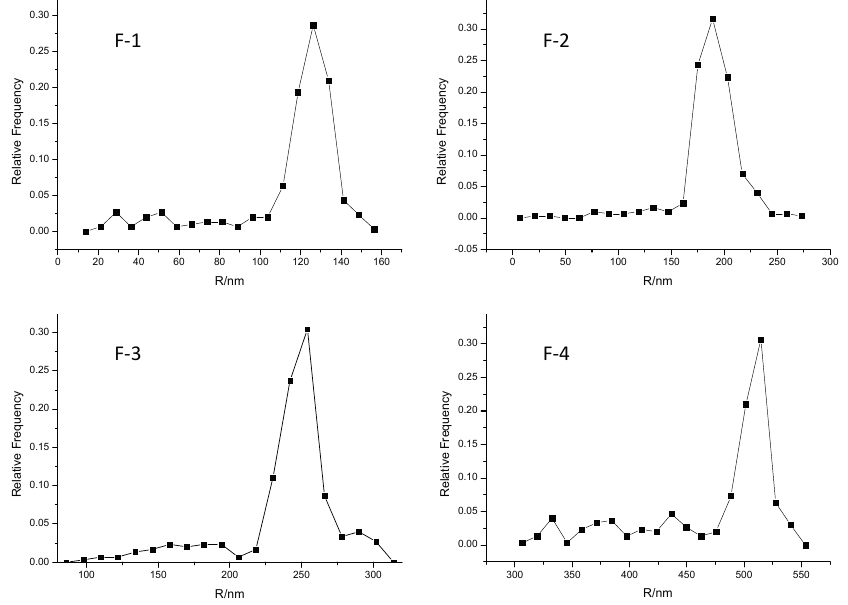
Figure2. The particle size distribution graph of molecules in Fenge water